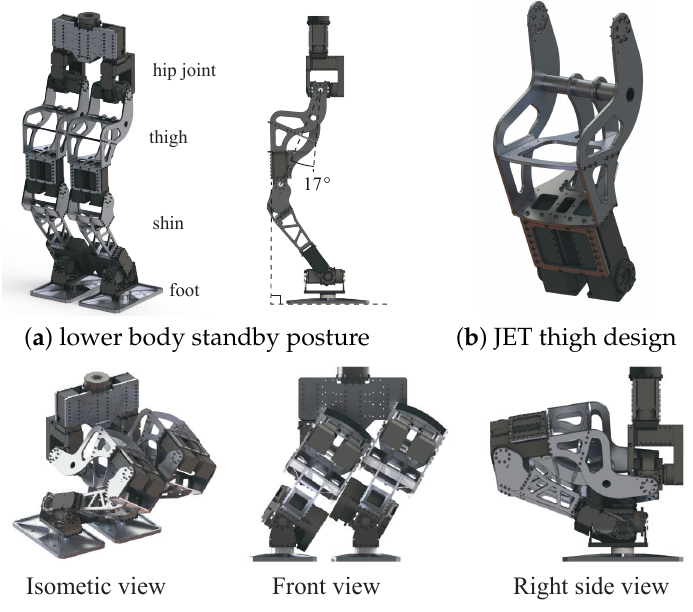
Figure 5. Lower limb design: ( a ) lower body standby posture, ( b ) thigh design, ( c ) lower body squatting pose. The lower body frames were designed to avoid self-collisions. In particular, the thigh frames were designed such that the link front surfaces are perpendicular to the